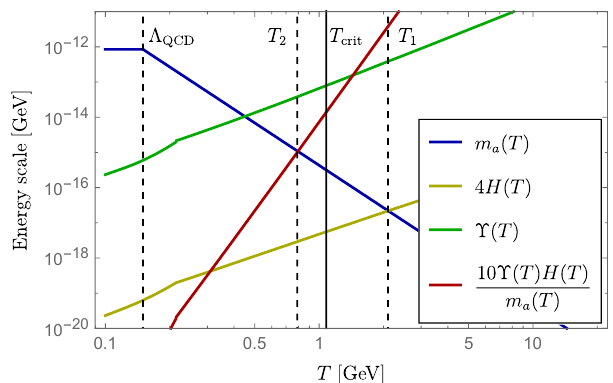
Figure 5 . An example of the scenario that could open up the parameter space for QCD axion dark matter. The vertical lines represent the relevant scales defined in eq. (5.5) except for Λ which is too low to be seen in the panel. Normally the onset of oscillations occurs at T , however the friction can 1 delay the onset at most until T . If the dark sector spontaneously breaks at T then the correct 2 crit abundance is obtained. For this example we used f = 10 10 GeV , λ = 10 5 and Λ = 10 − 3 GeV . a